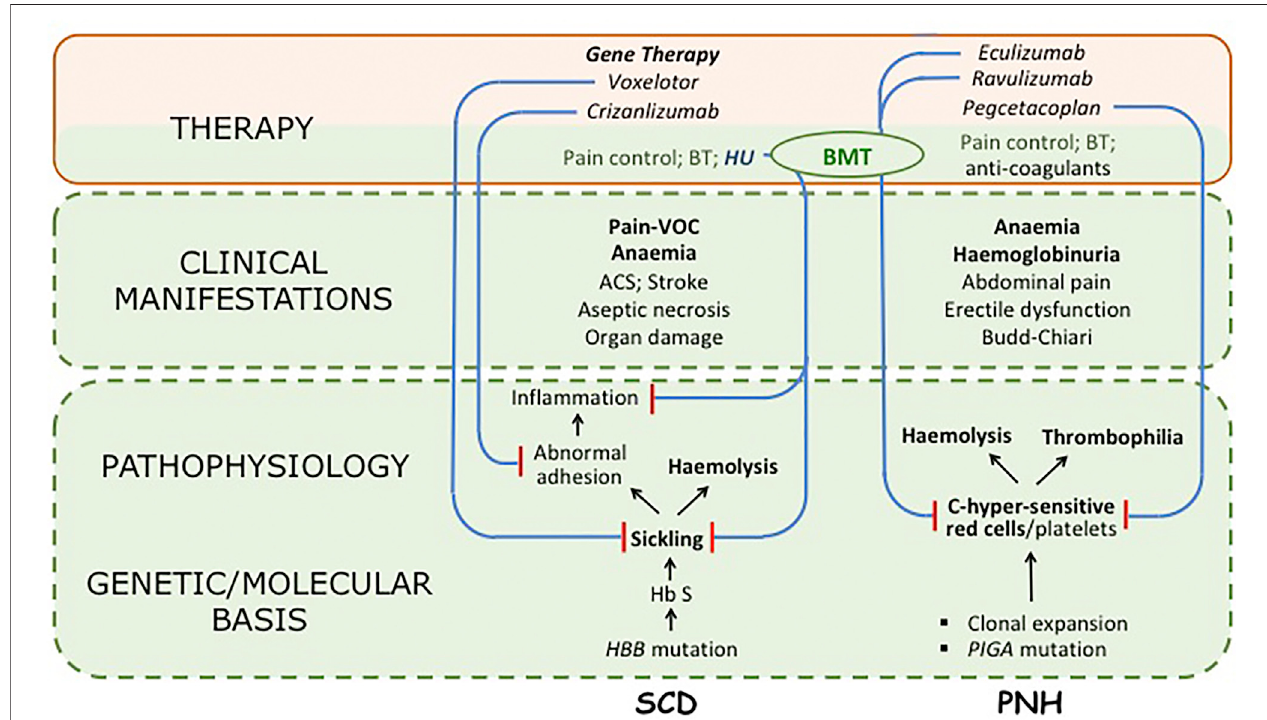
FIGURE 1 | Synoptic view of two Rare Diseases, sickle cell disease (SCD) and paroxysmal nocturnal haemoglobinuria (PNH), and of drugs used in their treatment. Forboth diseases the pathophysiology iscomplex;butinSCDtheprimaryproblemisclearly sickling,whereasotherfeatures areimportantconsequences, particularly a chronicin fl ammatory state; inPNH theprimaryabnormalityisinthede fi ciencyoftheGPI-linked surfaceproteinsCD55and CD59, thatmakeboth red cells andplatelets exquisitely sensitive to activated complement (C) (although it is not yet certain whether the marked thrombophilic tendency is a direct consequence of the platelet abnormalityoranindirectconsequenceofintravascularhaemolysis).Forbothdiseasesonlymajorclinicalmanifestationsarelisted(VOCstandsforvaso-occlusivecrisis). Regardingtherapy,long-establishedsupportivemeasuresareingreentype;drugsareinitalic;curativetreatmentsareinbold:allothertreatmentsaredisease-modifying. Blue lines ending in red bars indicate the mechanism of action of targeted drugs; in PNH each drug inhibits in one way or another activation of complement (eculizumab and ravulizumab bind to C5; pegcetacoplan binds to C3: for details see (Luzzatto, 2021)). BT stands for blood transfusion; BMT indicates bone marrow transplantation (used successfully in both SCD and PNH). The area shaded in light green re fl ects the body of work that has led to identi fi cation of the molecular basis of the disease including the genetics, biochemistry and pathophysiology of SCD and PNH; there is also the body of experience regarding their clinical features, acquired over decades (orcenturies)ofbasicandclinicalresearch.TheareashadedinlightpinkcomprisesinnovativetherapeuticmeasuresproducedbyPHARMA,basedonwhatwasknown inthegreenarea,withtheincentivesandadvantagesaffordedbyOrphanDrugDesignation(ODD).Weareunabletoprovide,foreitherSCDorPNH,a$ fi gureforwhatis in green, and for what is in pink; however, we contend that a 5:1 ratio may not be an over-estimate. Hydroxyurea (HU) is an important case in point: this compound has been a drug for three-quarters of a century, and has been used in SCD over the last quarter. However, a new formulation, Siklos (containing in one capsule either 1,000 mg or 100 mg instead of500 mg) has received designation asan orphan drug: the price per Gram is $16.50insteadof about $1. Inpractice, Siklos(notshown in the fi gure) has managed to move HU from the green area to the pink area.